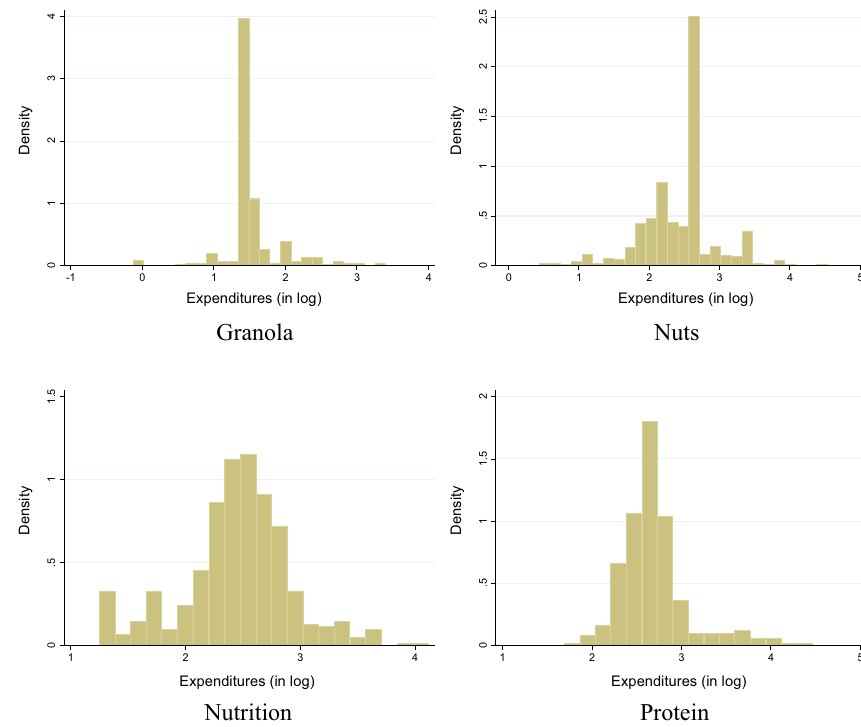
Fig. 3 Distributions of hemp products expenditures in natural logarithm